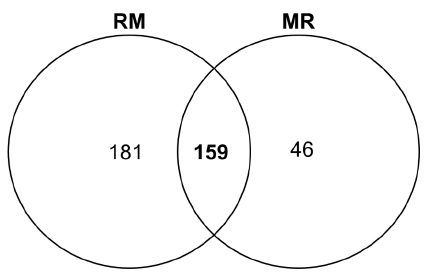
Figure 1. Venn diagram of the proteins identified. Number of proteins identified in each treatment (exclusive), the intercept containing the number of proteins common in both treatments. RM = re- striction maintenance; MR = maintenance restriction. Controlling the p -value adjusted (FDR) < 0.05, a total of 13 proteins were differentially abundant between treatments (Figure 2, Table 1). Among them, ATP-dependent 6-phos- phofructokinase (PFKM), dihydrolipoyl dehydrogenase (DLD), lipoyl-binding domain- containing protein (DLST), S-formylglutathione hydrolase (ESD), IF rod domain-contain- ing protein (DES), triosephosphate isomerase (TPI1), and 5 uncharacterized proteins cor- responding to the genes FLNC , HSPA9 , SELEMBP1 , and MYOM1 were more abundant in RM compared with MR (FRD < 0.05; Table 1). Calponin homology (CH) domain-contain- ing protein (SMTNL1) and pyruvate kinase (PKM) were less abundant in RM compared to MR (FDR < 0.05; Table 1).